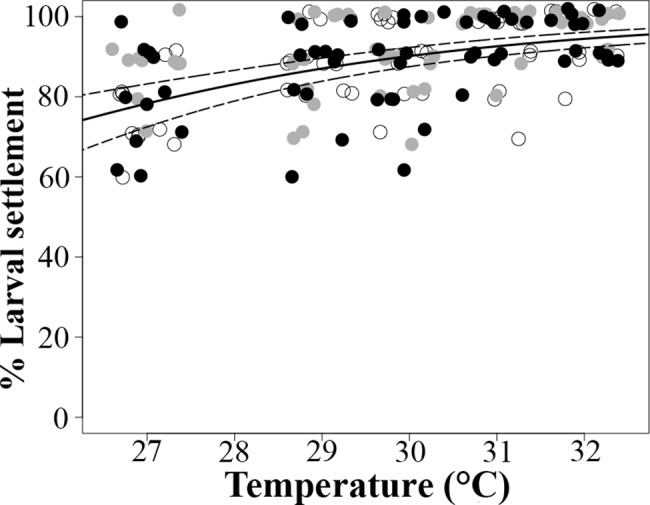
Proportion of 5 days old Acropora tenuis larvae, fertilized and reared under control conditions (27°C and FSW) but settled under different temperatures and nutrient enrichment [low (open circles), medium (grey circles), high (black circles); Experiment 2].Control treatment: ‘low’ nutrient enrichment and at temperature = 27°C. Solid lines indicate fitted GLM trends, dashed lines are 95% confidence intervals. Individual points are jittered horizontally for clarity.